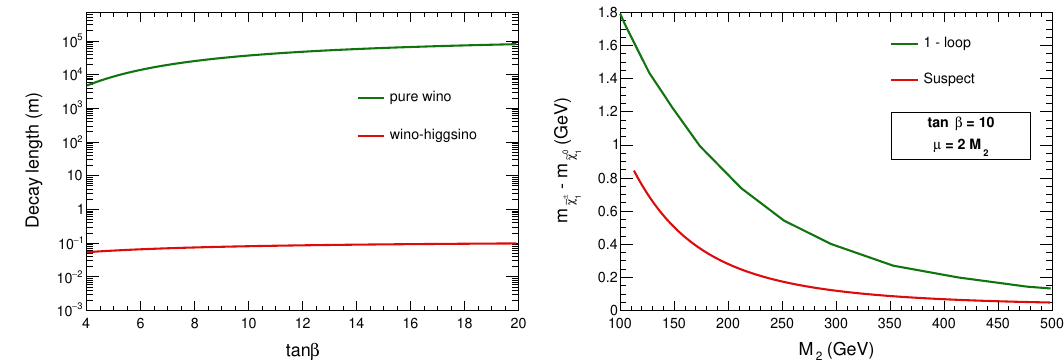
Figure 5. Decay length of a charged wino in pure wino state (green) and mixed state of wino- higgsino (red) in Suspect2 (left), and comparison of mass splitting ( ∆ m and 1-loop result [38] (right).